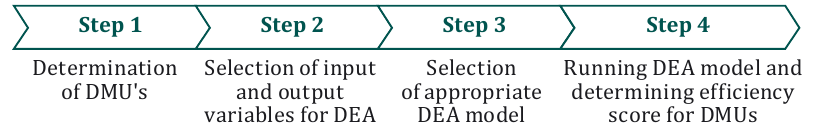
Running DEA model and DMUsSelection determining efficiency of appropriate score for DEA